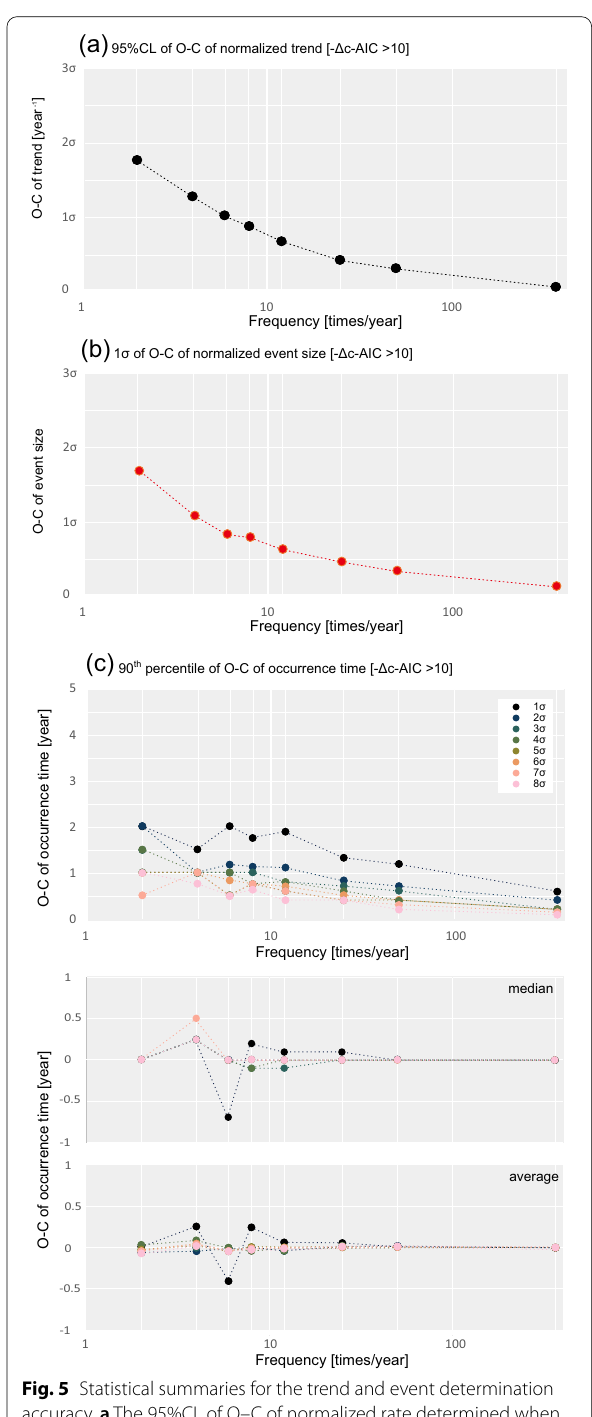
Fig. 5 Statistical summaries for the trend and event determination accuracy. a The 95%CL of O–C of normalized rate determined when the threshold of –Δc‑AIC is 10. b The standard deviation of O–C of normalized event size determined when the threshold of –Δc‑AIC is 10. c Occurrence time determination accuracy: the 90th percentile, median and average of O–C of occurrence time determined when the threshold of –Δc‑AIC is